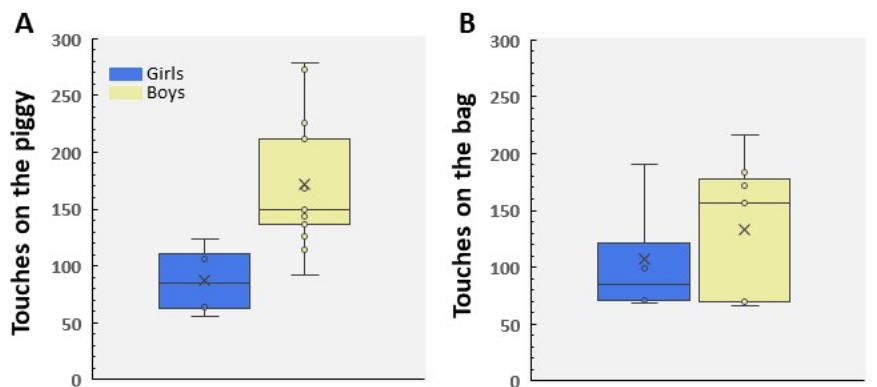
Figure 3. Mean of touches to the piggy ( A ) and to the bag ( B ) in the HR group. The number of participants in each group was 20 boys and 8 girls. The distribution by gender was as follows: HR to the pig (boys n = 13; girls n = 4) and HR to the bag (boys n = 7; girls n = 4).